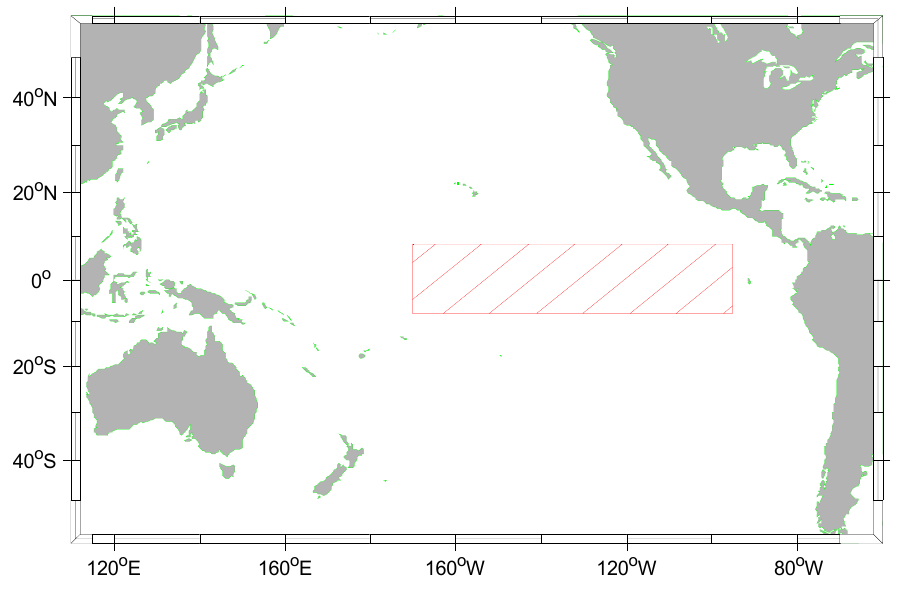
Figure 1. The red rectangle represents the study area from 8 ° S to 8 ° N in latitude and from 95 ° W to 170 ° W in